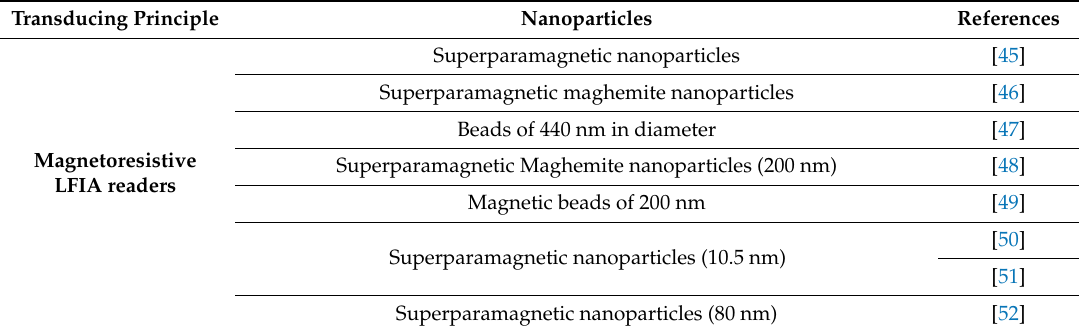
Table 2. Type of magnetic nanoparticles used for each magnetic transducing